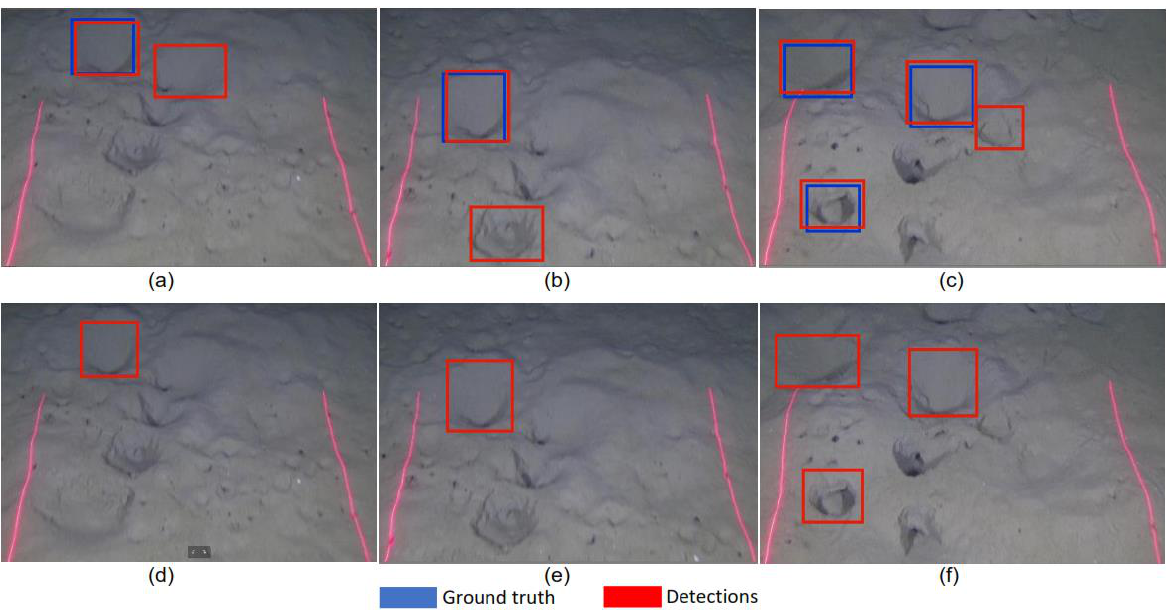
Figure 10. False positive suppression using detection refinement algorithm ( a – c ) are the ground truth (blue color bounding boxes), and original detections from Inception model (red color bounding boxes) ( d – f ) are the refined detections.